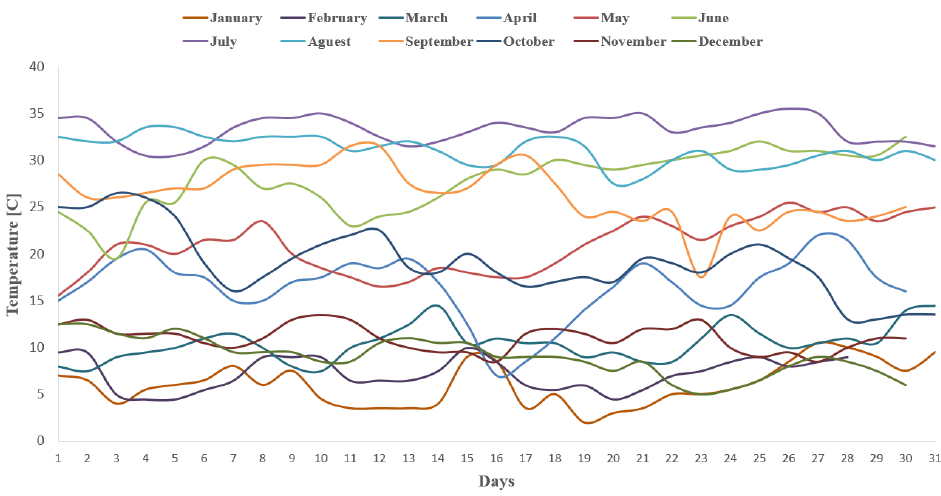
Figure 6. Mean values of daily temperature changes in different months for Tehran city [39].